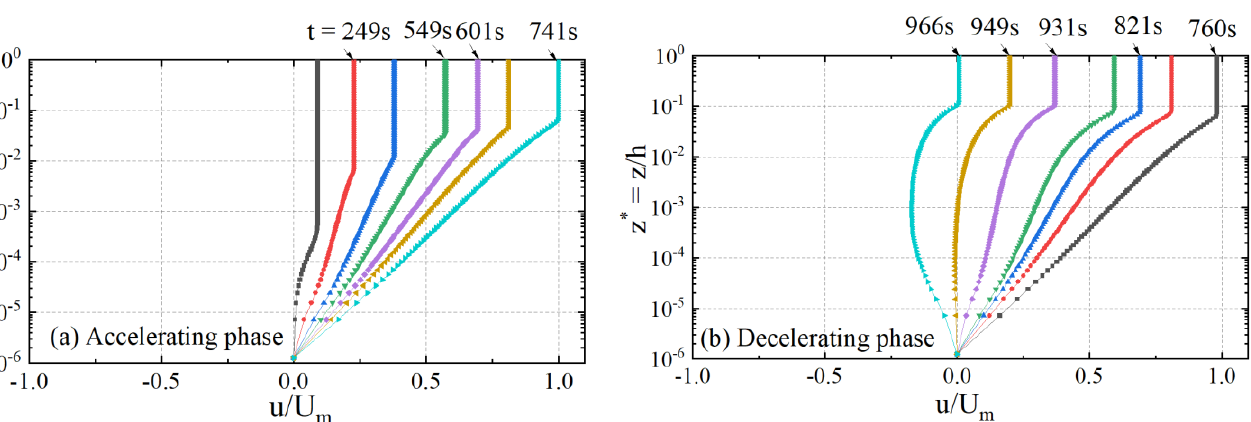
Figure 11. Flow velocity distribution under the observed tsunami at the GPS No.4 during ( a ) the accelerating phase and ( b ) the decelerating phase. 3.2.6. Tsunami-Induced Bottom Shear Stress Figure 12 shows the time variation in the bottom shear stress obtained using the k- ω model at three measuring stations (No.2, No.4, and No.5) among the six stations in Table